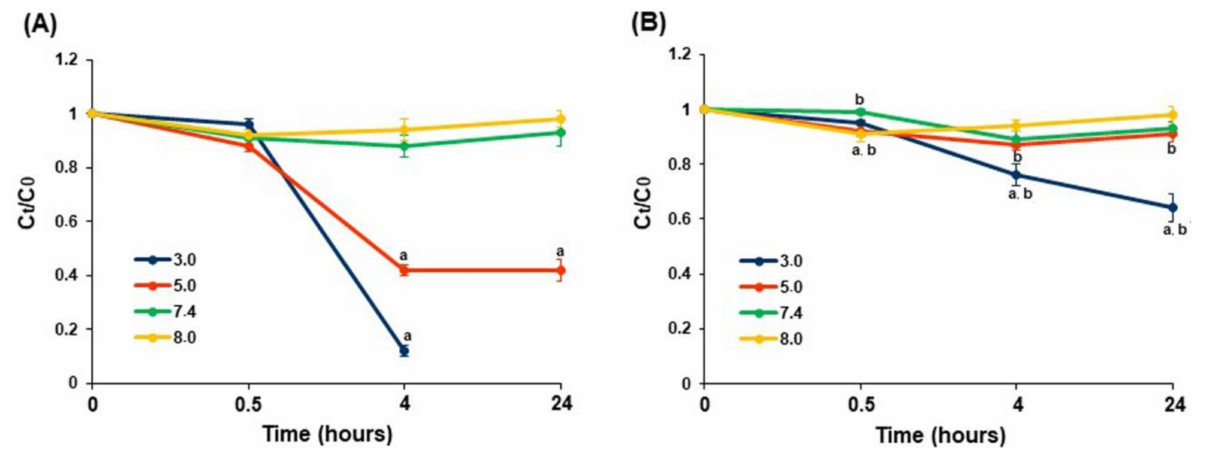
Figure 9. The BSA adsorption by AP4 ( A ) and HS4 ( B ) gel beads incubating in PBS at different pH for 24 h. The data are presented as the mean ± S.D. ( n = 5). a p < 0.05 vs. PBS at pH 7.4; b p < 0.05 vs. the corresponding AP4 gel beads. The BSA adsorption is expressed as the relative protein concentration C t /C 0 , where C 0 and C t are the initial and remaining concentrations of BSA in PBS at different time points after incubation, respectively.